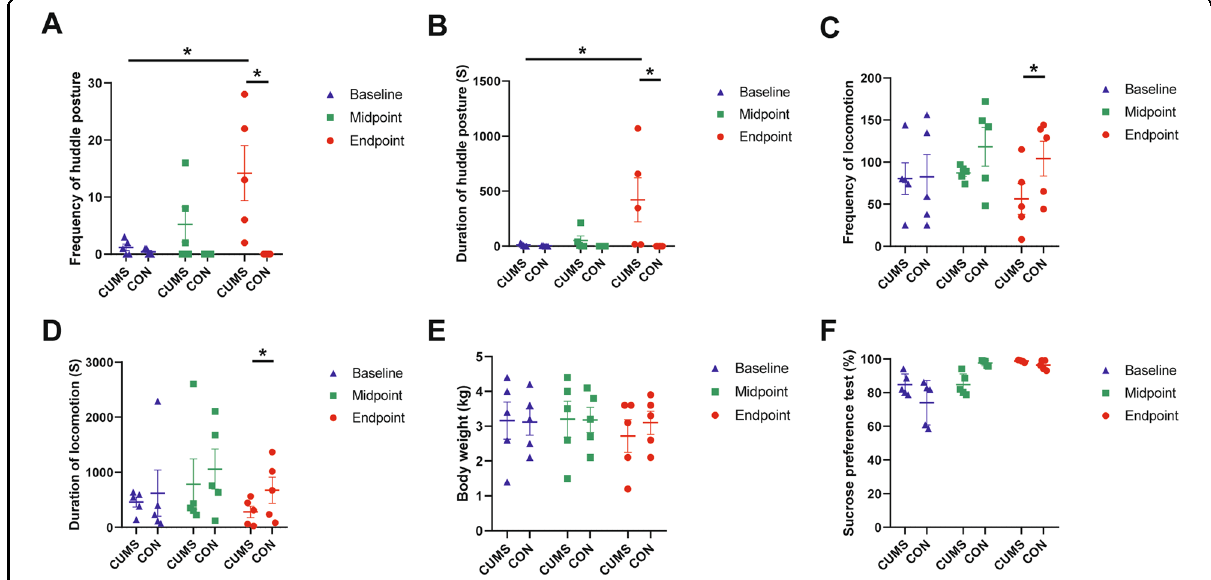
Fig. 2 The results of the huddle posture, locomotion, body weight and sucrose preference test in CUMS and CON groups at baseline, midpoint (after three stress cycles) and endpoint (after fi ve stress cycles). A The frequency of huddle posture. B The duration of huddle posture. C The frequency of locomotion. D The duration of huddle locomotion. E Body weight. F Sucrose preference test. * P <